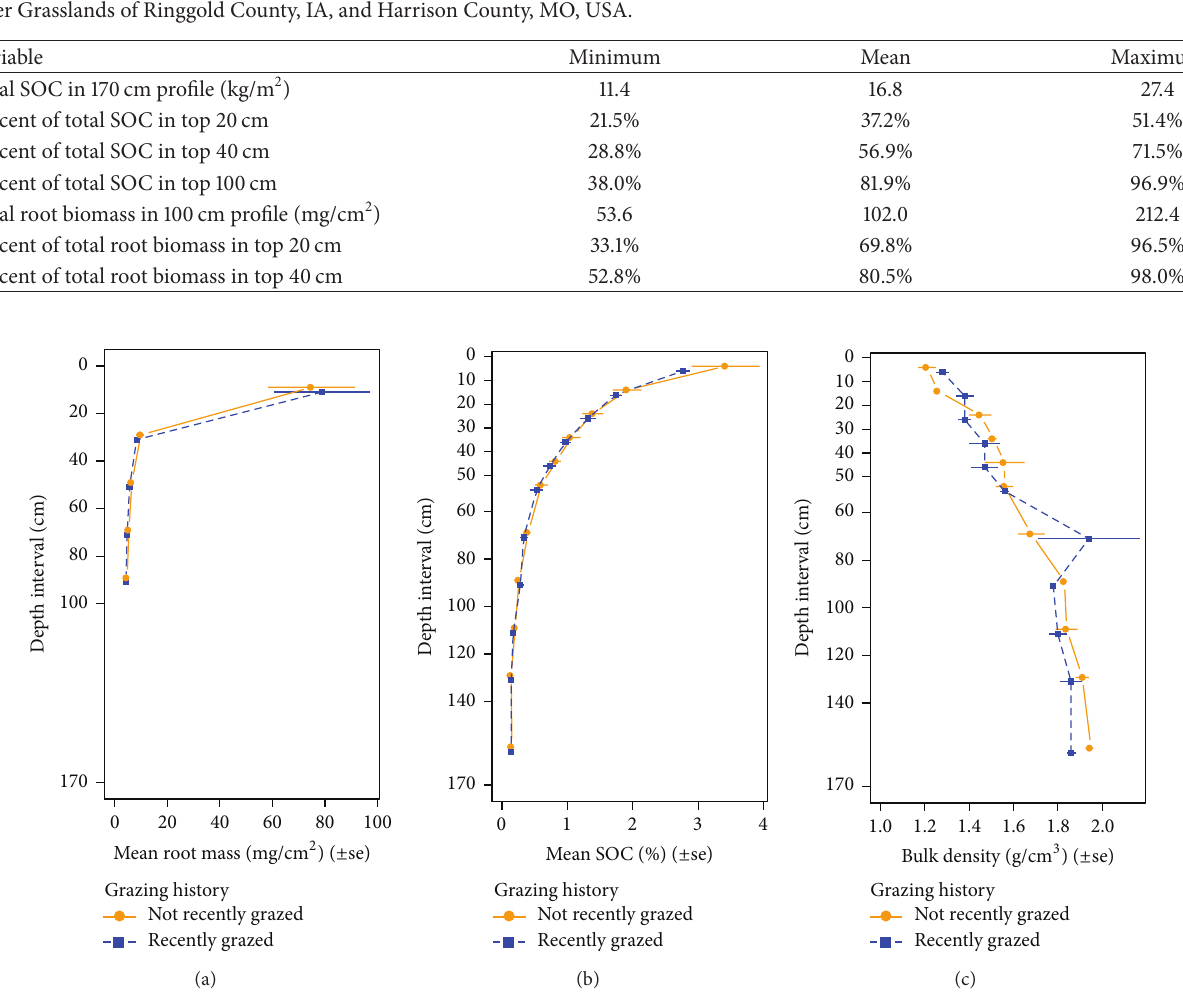
Figure 1: Root biomass, soil organic carbon (SOC), and bulk density for six tallgrass prairie pastures in the Grand River Grasslands of Ringgold County, IA, and Harrison County, MO, USA, plotted by depth (0–170cm) and grazing history. See Methods for sampling procedures including depth